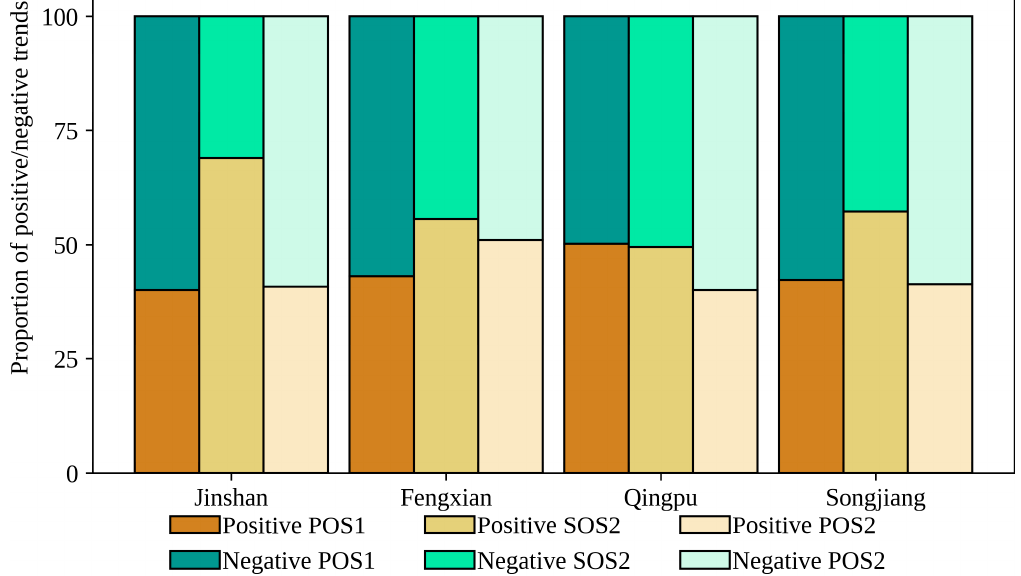
Figure 6. Proportion of significant ( p -value < 0.05) positive (slope > 0) and negative (slope < 0) trends of the phenological metrics from 1993 to 2009 in four counties of Shanghai.